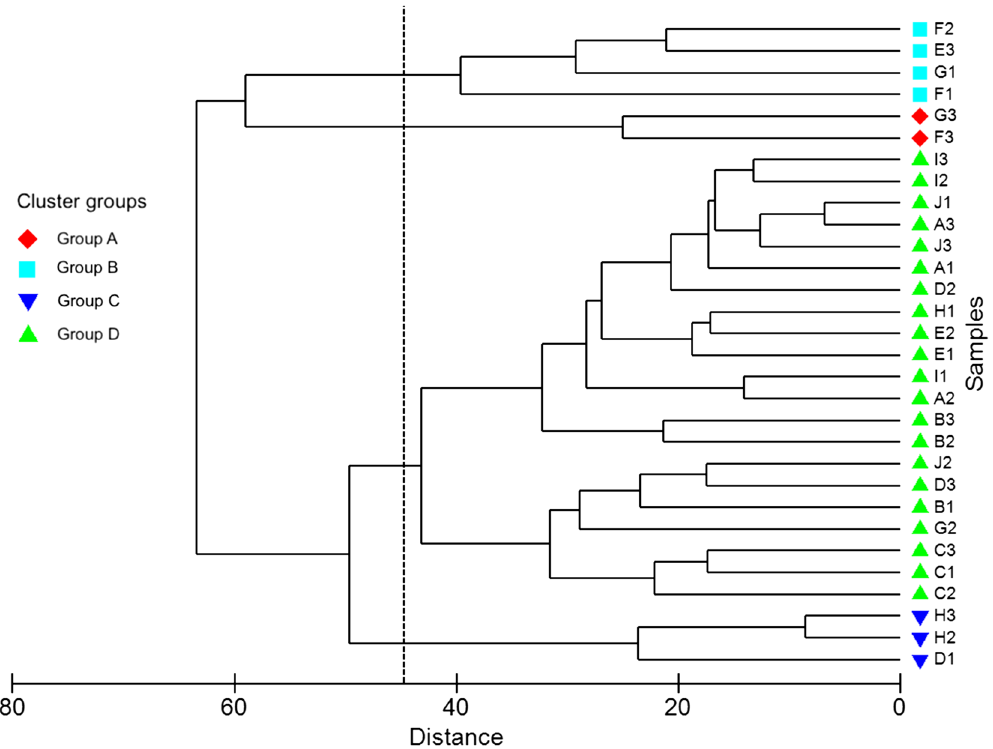
Figure 4. Dendogram produced by cluster analysis based on the complete linkage of benthic foraminiferal assemblages around Pulau Tioman. The stations in Pulau Tioman are divided into four groups (i.e., Group A , B , C and D ) represented by the symbols are based on the distribution of benthic foraminifera assemblages. The distance represents Euclidean